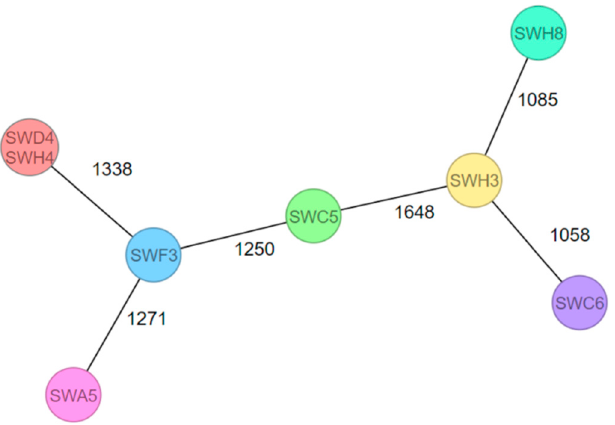
Figure 1. cgMLST MST of eight L. monocytogenes isolates from drains (SWH8, SWC6, SWH3, SWC5, SWF3, and SWA5) and from processing water for a salad-washing system (SWD4 and SWH4). The allele distances are indicated. Identical isolates are grouped within a common circle.